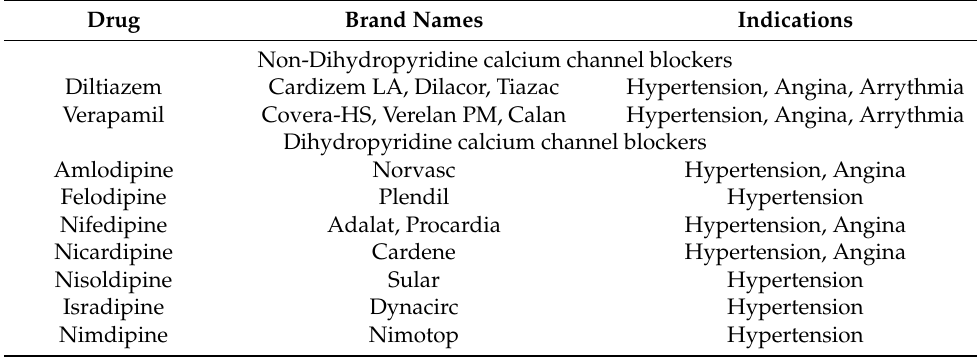
Table 1. Chart represents classes of calcium channels blockers, their trade names and the disorders they are used for.